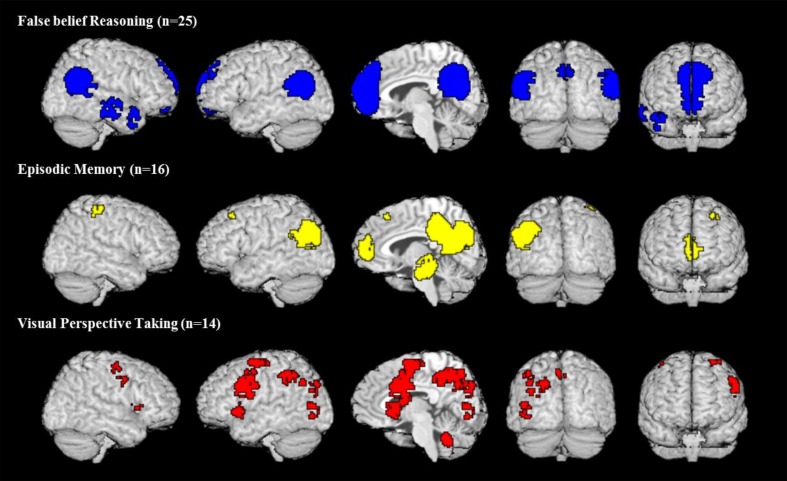
Activation maps of meta-analyses for three different domains. All maps are thresholded at voxel-wise threshold of p < 0.005 uncorrected and a cluster extent threshold of 10 voxels. Activations of all meta-analyses are superimposed on the Talairach template.